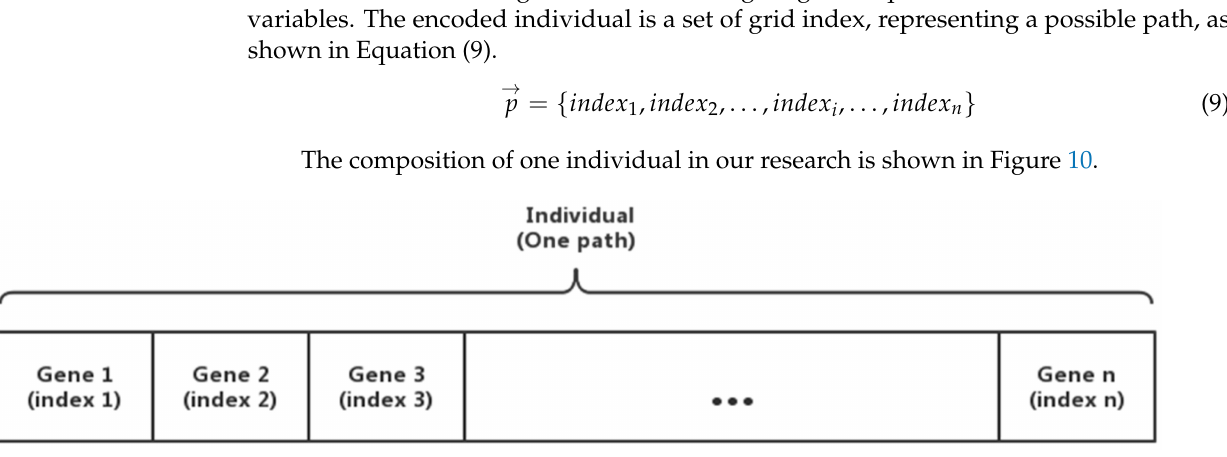
Figure 10. Composition of one